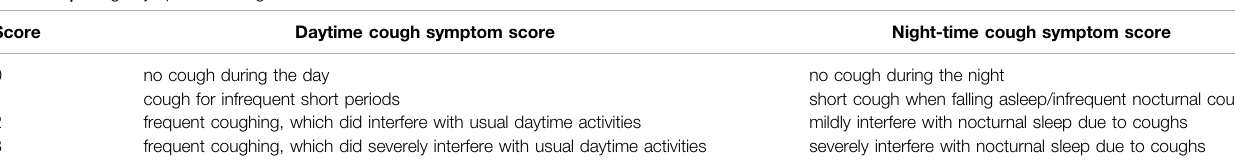
TABLE 2 | Cough symptom scoring criteria.